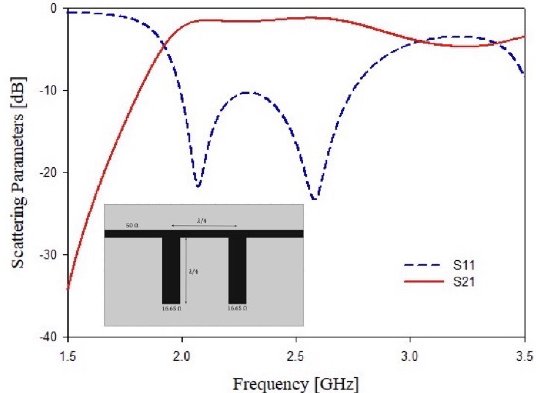
Figure 2. Second order standard band pass filter. Microstrip implementation and simulated scattering parameters S 11 and S 21 .